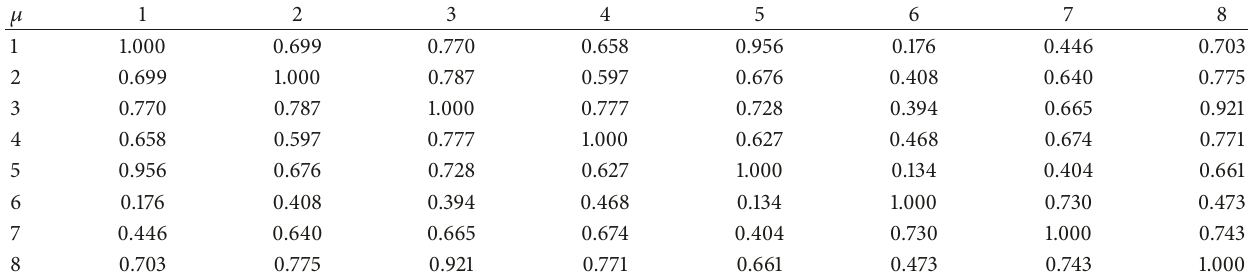
Table 1: Membership parts of the intuitionistic fuzzy pairs, giving the intercriteria correlations between measurements of crude oil probes. 𝜇